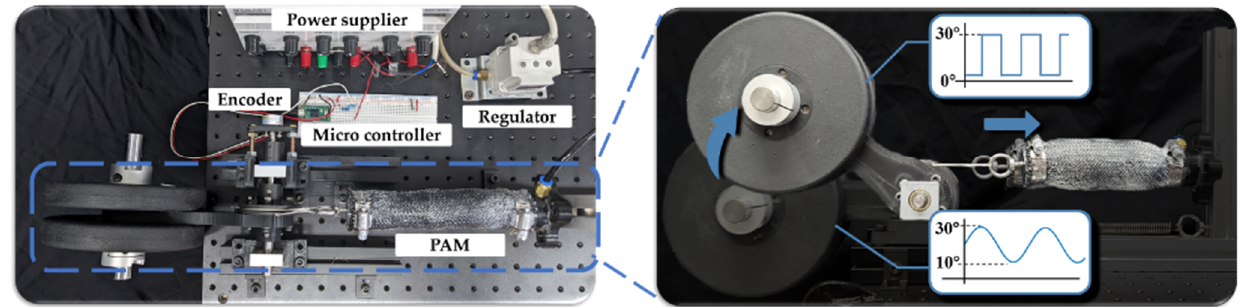
Figure 5. ( a ) The contraction force comparison of the McKibben muscle and SFCCM PAM at 200 kPa pressure. ( b ) Force versus contraction length values of the SFCC PAM at pressure range of 50–200 kPa.